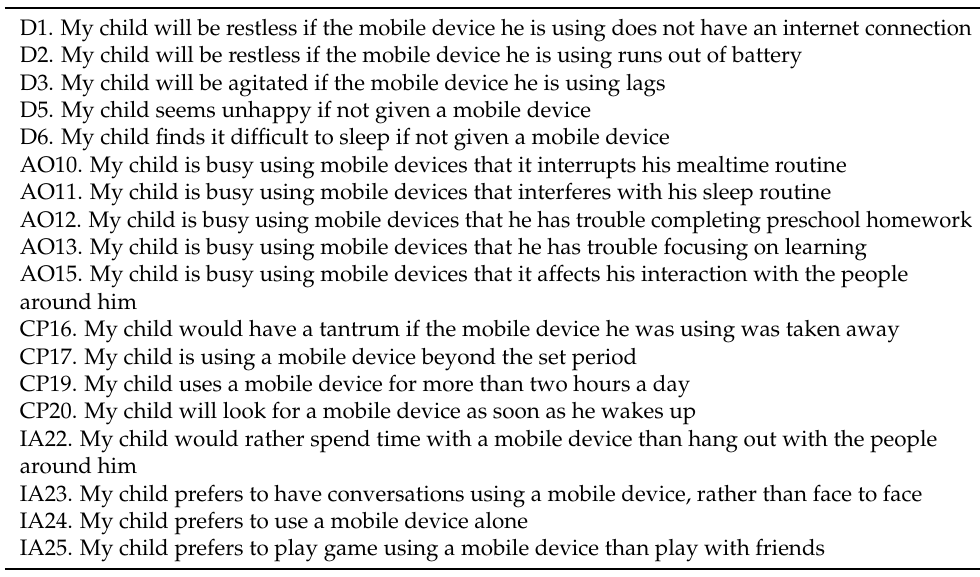
Table A1. Adapted Version of